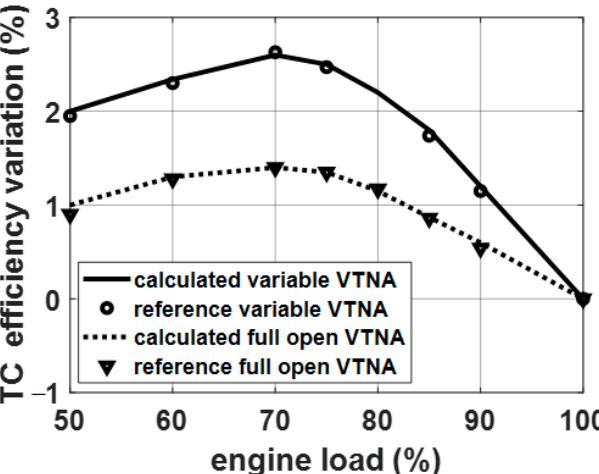
Figure 5. VTNA turbocharger efficiency comparison between simulation and reference data.